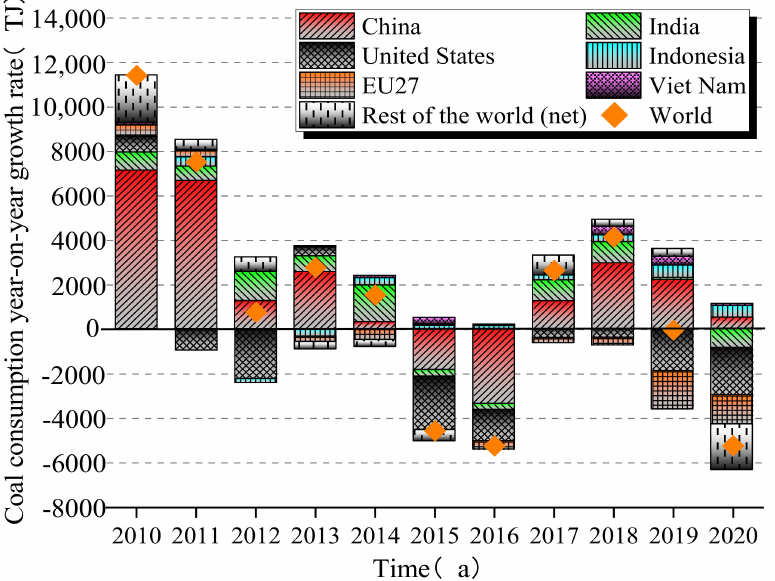
Figure 1. The coal consumption year-on-year growth rate of the world since 2010 (data from Interna- tional Energy Agency Statistics, 2020).